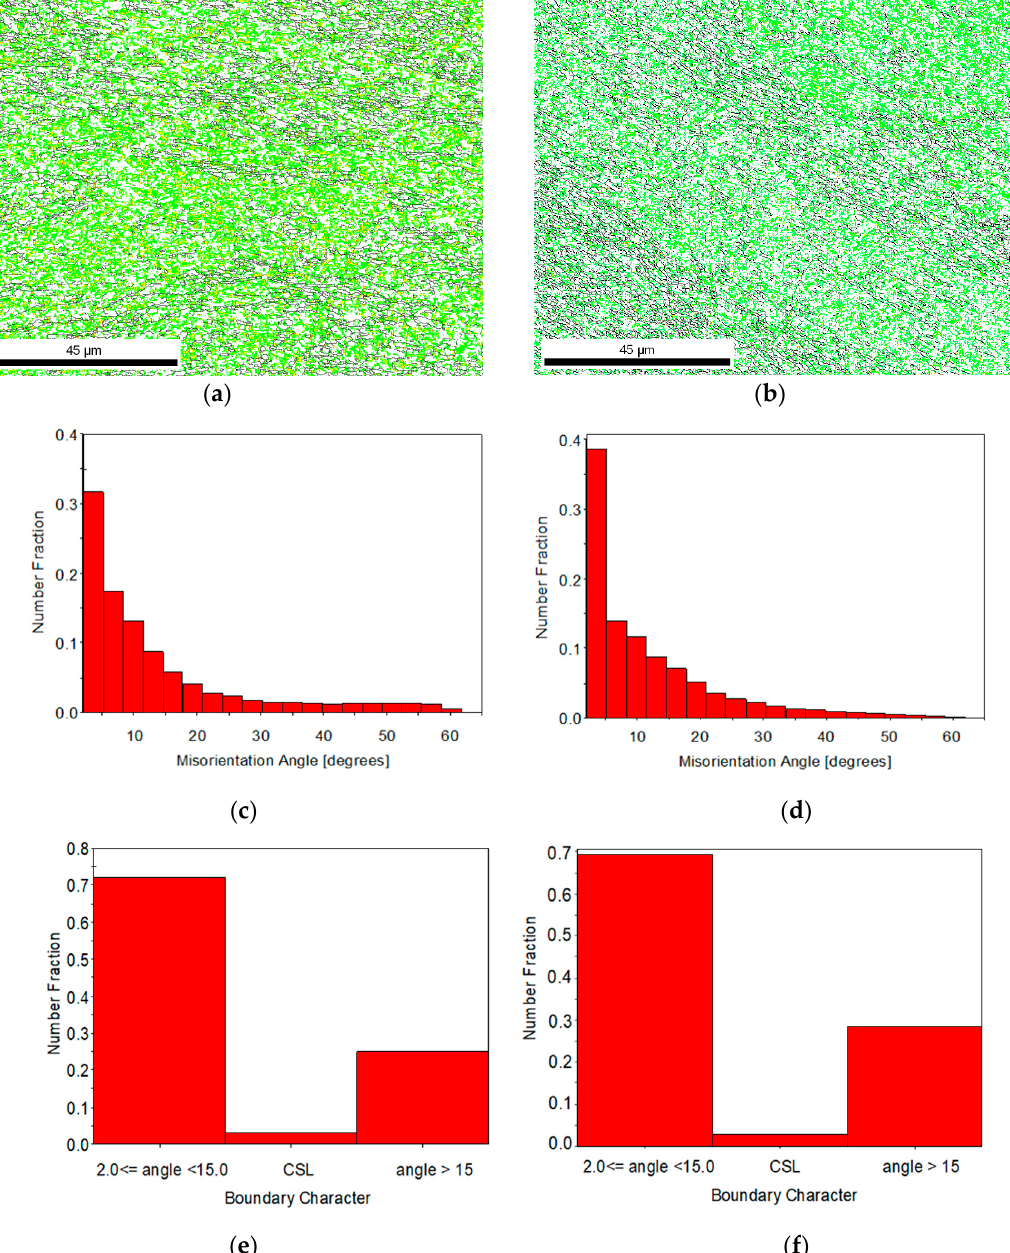
Figure 2. Electron back scattered diffraction (EBSD) results after eight passes of CCDF: texture maps of ( a , b ) AA1050 pre-annealed at low temperature and ( c , d ) AA1050 after pre-annealing at high temperature.